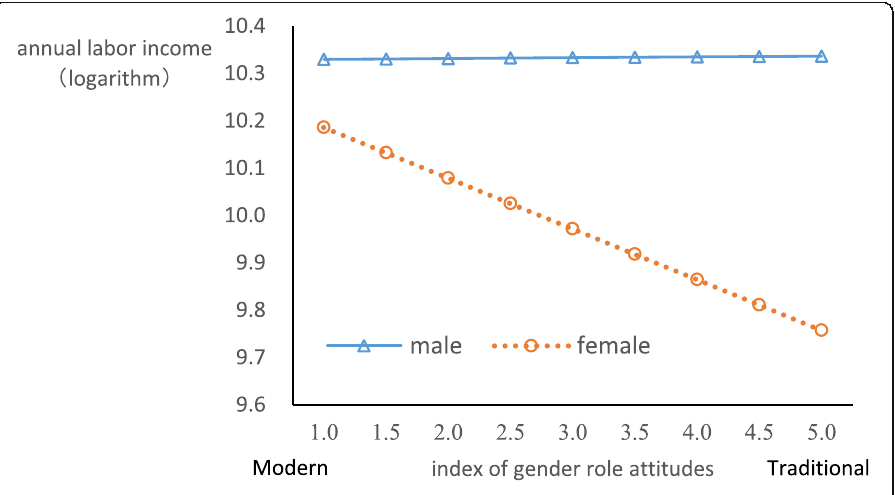
Fig. 2 The interaction effect of gender and gender role